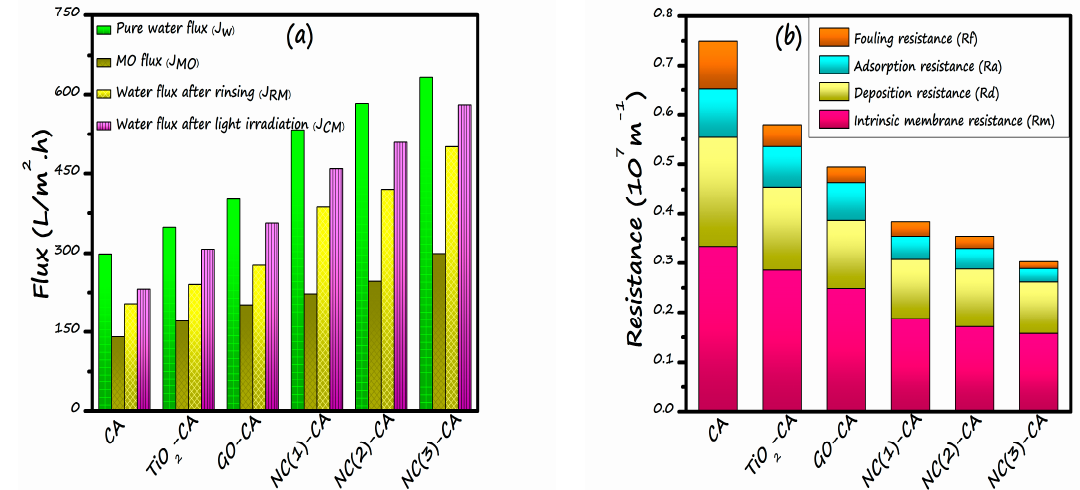
Figure 13. ( a ) Flux calculated at the various processes (pure water flux, MO flux, water flux after rinsing, and water flux after light irradiation), ( b ) Evaluation of the filtration resistances for different membranes.